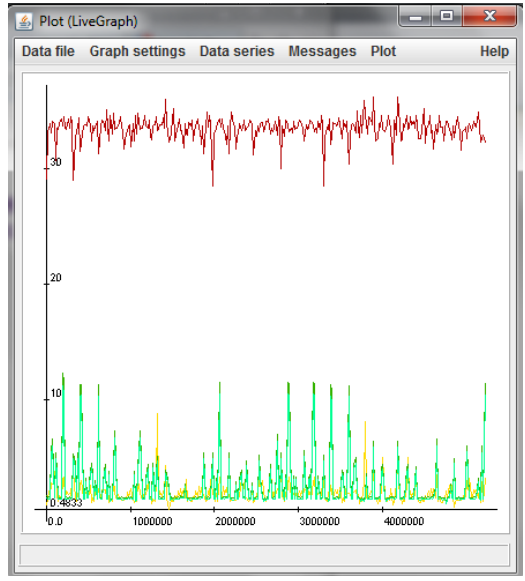
Figure 13. LiveGraph Continuously Updating Adjustable Graph from Real-Time Sensor